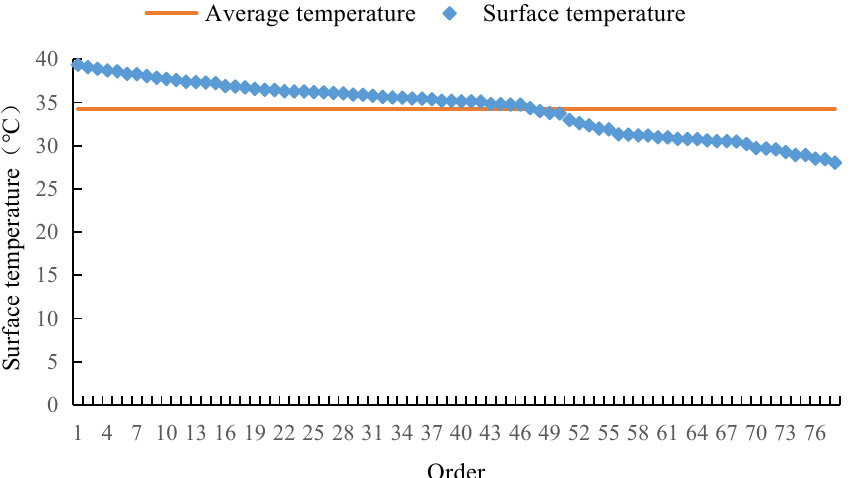
Figure 7. Spatial distribution of surface temperature of blocks in Dalian.